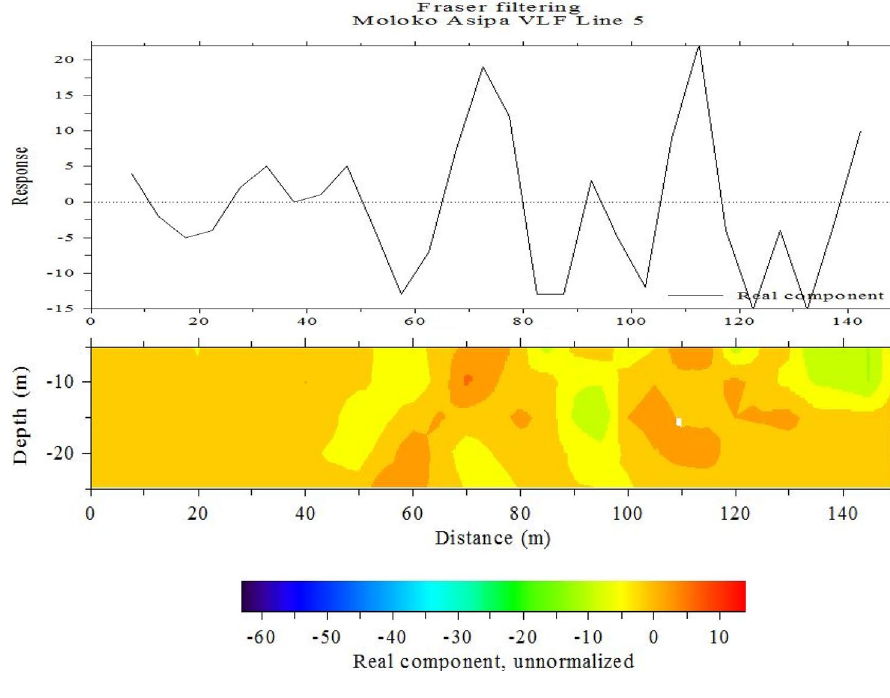
Fig. 6 Fraser and Karous–Hjelt representation for traverse 4